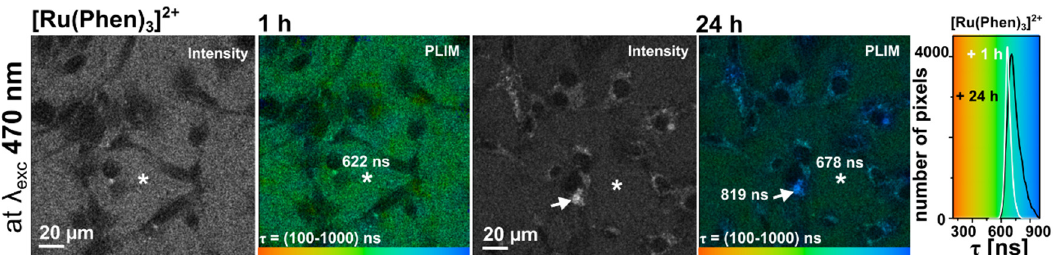
Figure 5. Four images on the left: Illustrative intensity and PLIM images obtained with 200 µM [Ru(Phen) 3 ] 2+ applied in the culture medium of U87 MG cells for 1 and 24 h. Right: [Ru(Phen) 3 ] 2+ luminescence lifetime distribution histograms (1 h—white, 24 h black). The luminescence lifetimes are color-coded (100 ns—red, 1000 ns—blue). The samples were excited with laser light at 470 nm. The white arrows point to intracellular and asterisks to extracellular localization of [Ru(Phen) 3 ] 2+ .